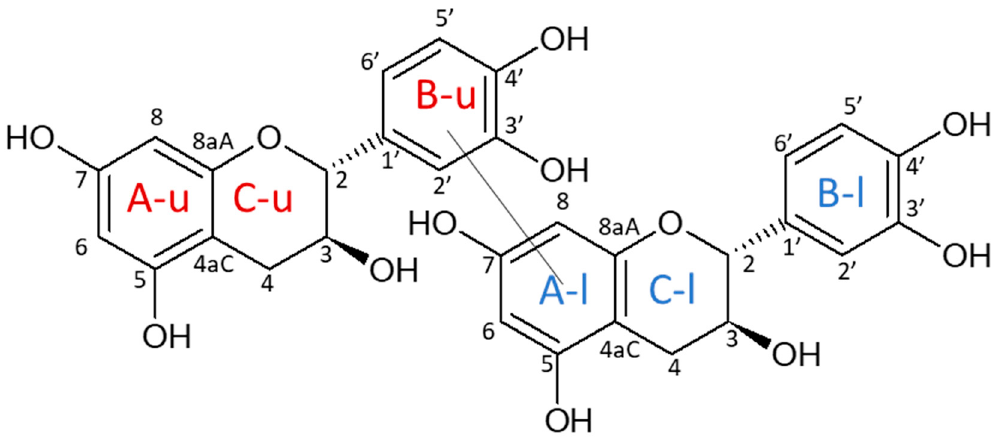
Figure 1. Example of a dimeric oxidation product. A, B, C rings are labelled with u for upper units and with l for lower units.